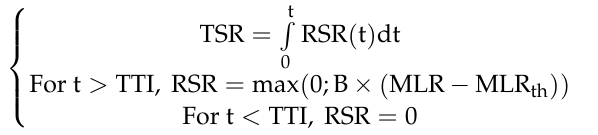
Figure 8. Optical density versus time ( A ) and mass loss versus time ( B ) for materials tested in smoke chamber at 25 kW/m 2 .